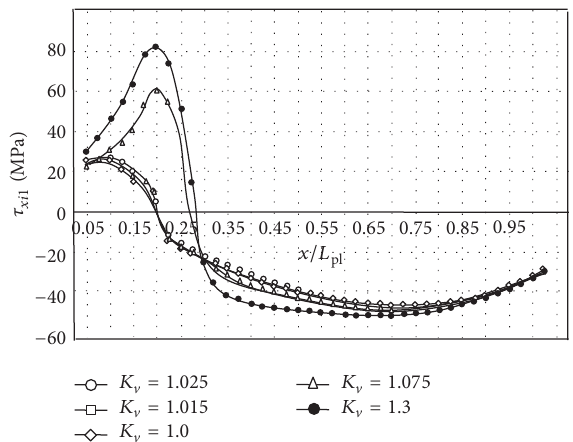
Figure 4: The calculated distributions of normal contact stresses along the zone of the surfacing, depending on the speed asymmetry coefficient (the initial thickness of compact material is 0.5 mm).